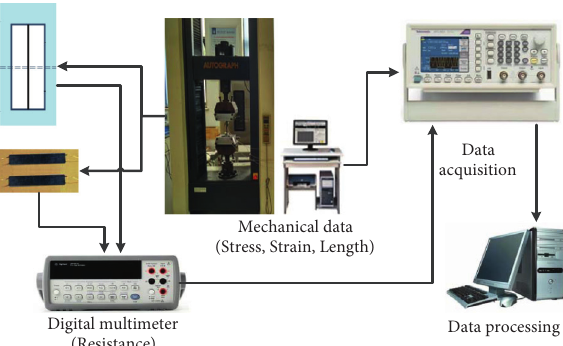
Figure 4: Schematic diagram of the strain-sensing experimental system of the carbon nanotube yarn sensor.